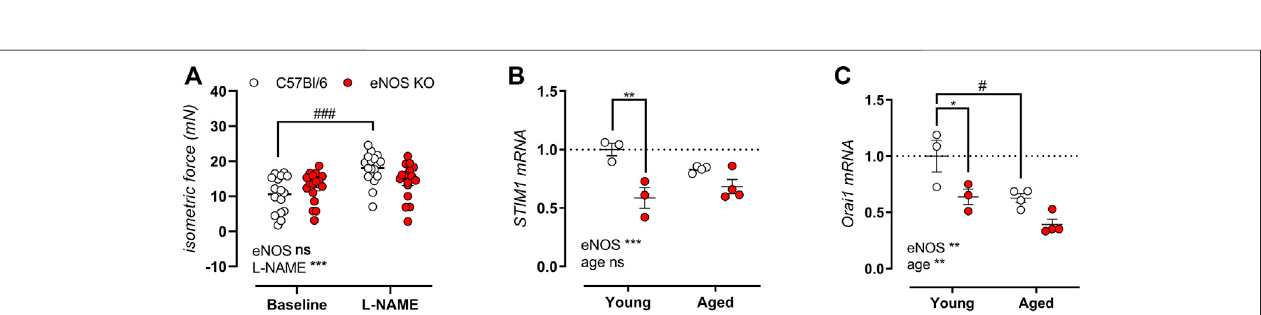
FIGURE9| PreservedSOCE-mediatedcontractionsineNOSknockoutmicedespitereducedgeneexpressionofSTIM1andOrai1.SOCE-mediatedcontractions werestudied in6-montholdeNOSknockout( n =14)and C57Bl/6control( n =12)intheabsenceandpresenceof300 μ M L -NAMEtoinhibitbasalNOproduction byre- addition of extracellular after emptying of the SR calcium stores (A) . Gene expression of STIM1 (B) and Orai1 (C) was assessed using qPCR on aortic tissue lysates of young (4 months, n = 3) and aged (13 months, n = 4) eNOS knockout and young (4 months, n = 3) and aged (14 months, n = 4) C57Bl/6 control mice. mRNA expression wasexpressed as a fold-change compared to youngC57Bl/6 control values. Statistical analysis waspreformed using two-way ANOVA. Overall signi fi cance (bottom) and post-hoc signi fi cance (in graph) are listed. ns, p > 0.05, *, p < 0.05, **, p < 0.01; ***, p < 0.001. ###, p < 0.001 for post-host testing of the effect of L -NAME in (A)